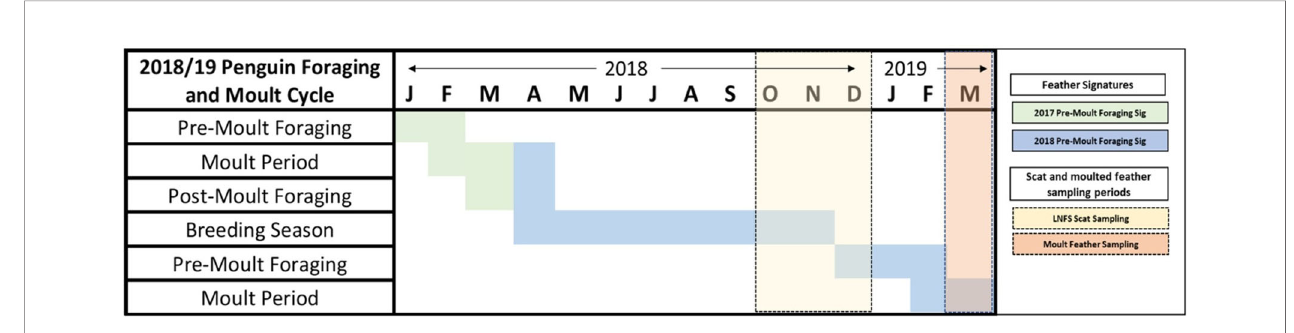
FIGURE 2 | Foraging and moult phenology of little penguins in Bass Strait. Blocks with horizontal lines correspond to the 2017 and 2018 pre-moult foraging signatures of feathers. Yellow and orange shaded blocks correspond to the sampling periods of seal scats and moulted penguin feathers